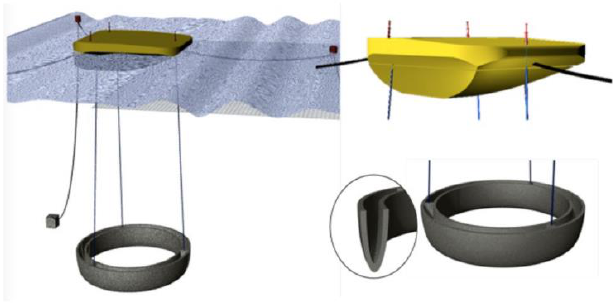
Figure 6: Oscilla Power Triton Architecture